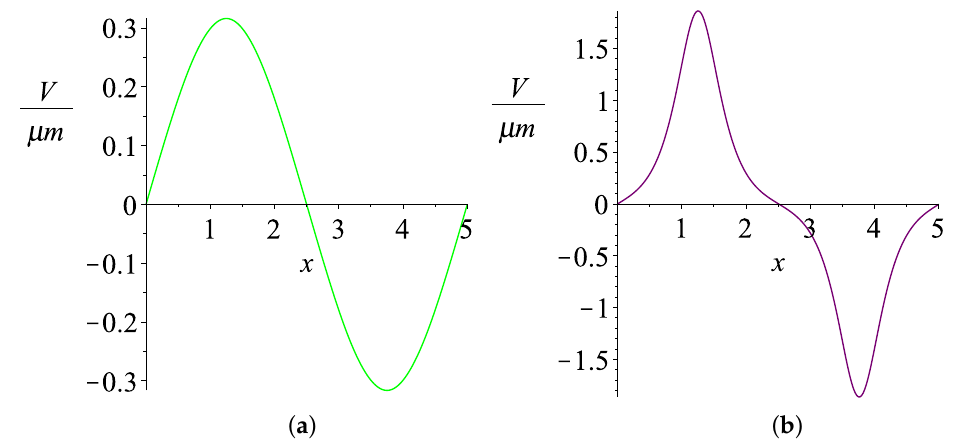
β α (green curve) corresponding to the propagation P